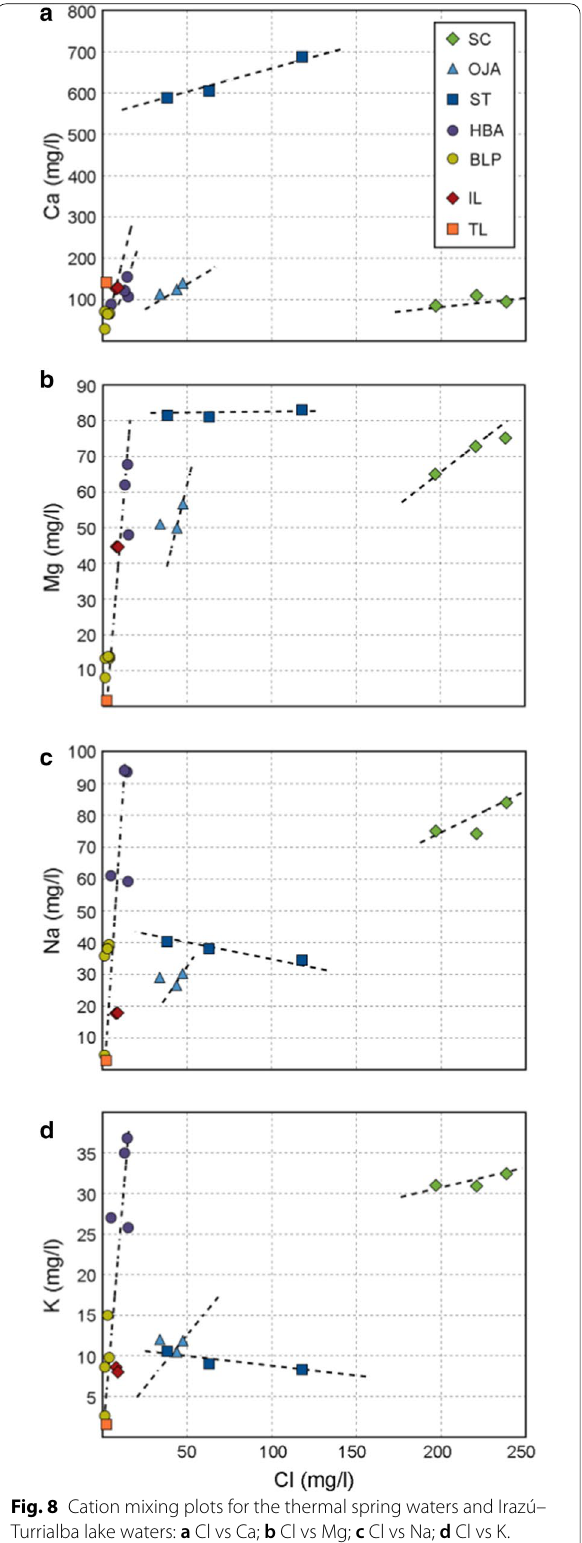
Fig. 8 Cation mixing plots for the thermal spring waters and Irazú– Turrialba lake waters: a Cl vs Ca; b Cl vs Mg; c Cl vs Na; d Cl vs K. Dotted lines illustrate the possible trends corresponding to dilution with meteoric waters (except for Santa